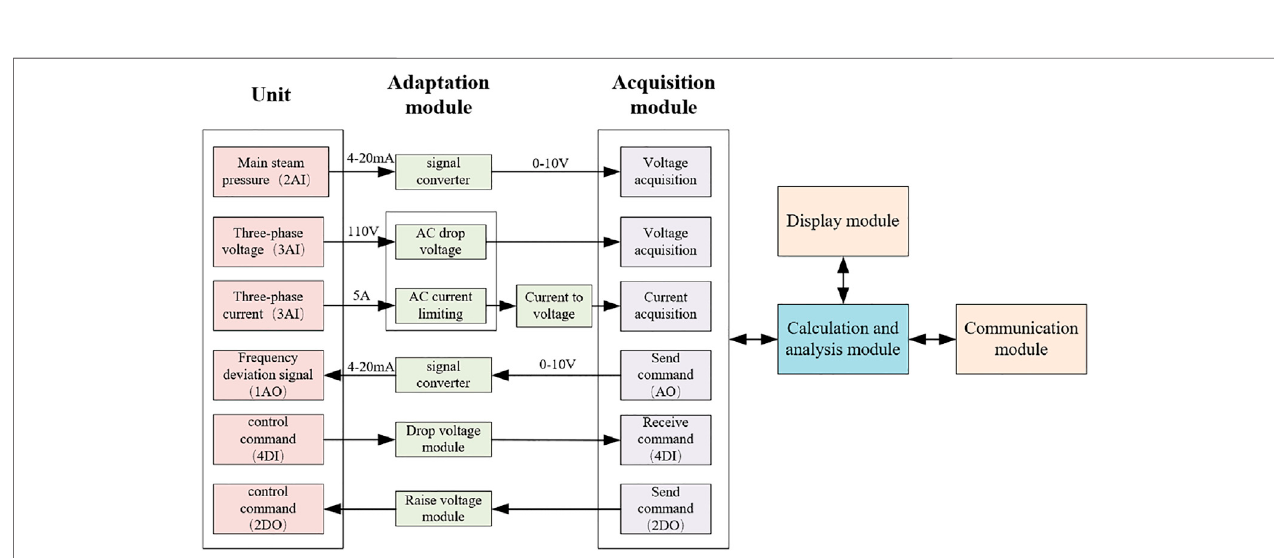
FIGURE 6 | Block diagram of the sub control station system con fi